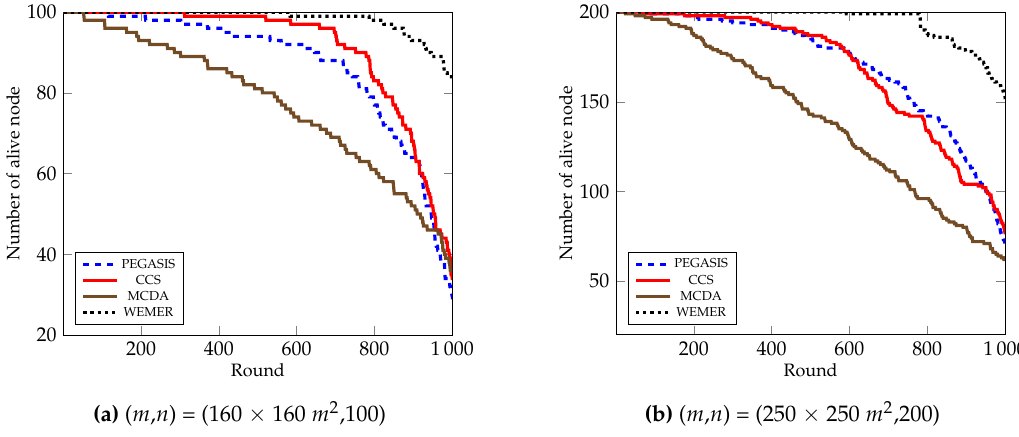
Figure 15. Number of alive nodes over round.